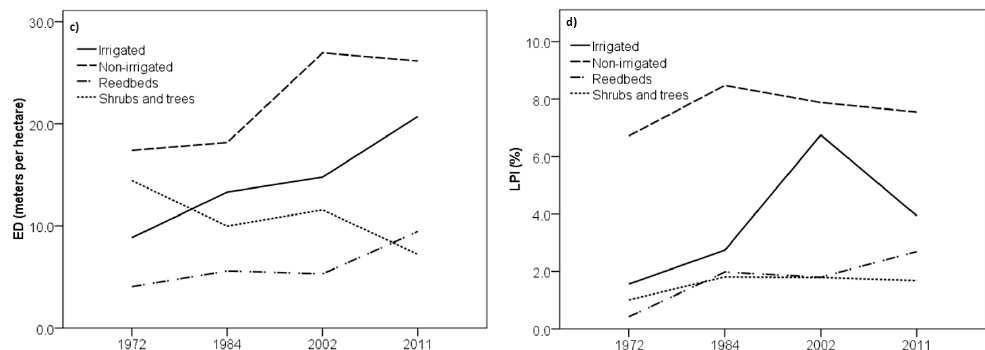
Figure 6. Lines represent changes of landscape metrics for four land cover/use classes (Irrigated, Non ‐ irrigated arable land, Reed beds, Steppic grasslands and Shrubs and trees) from 1972 to 2011. NP stands for Number of patches ( a ); PD stands for Patch density ( b ); ED stands for Edge density ( c ); and LPI stands for Largest Patch Index ( d ).